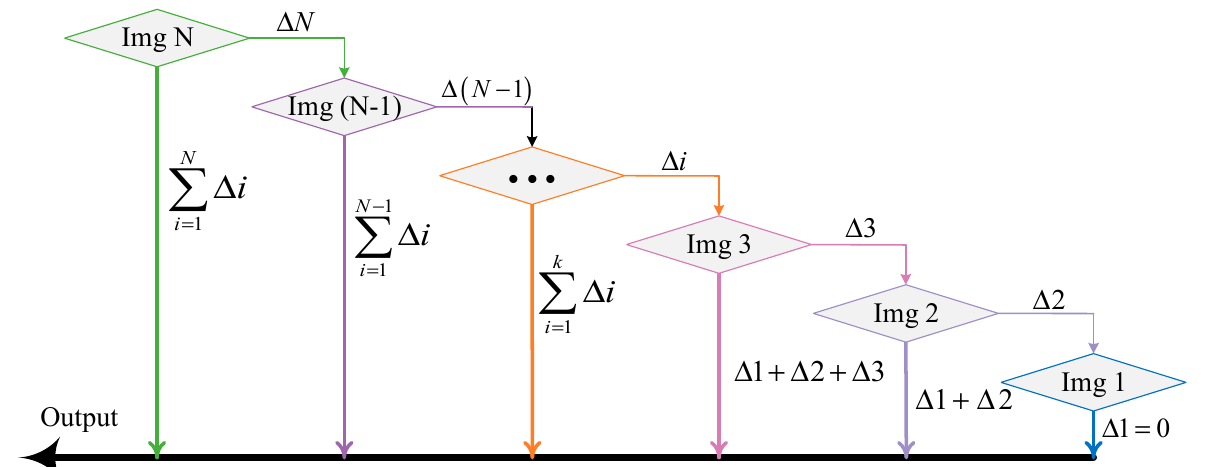
Figure 2. Process of the MISS1 method; ∆𝑖 represents the movement from an image to the next image. For Img i , the movement is the sum of the lengths from ∆1 to ∆𝑖 .